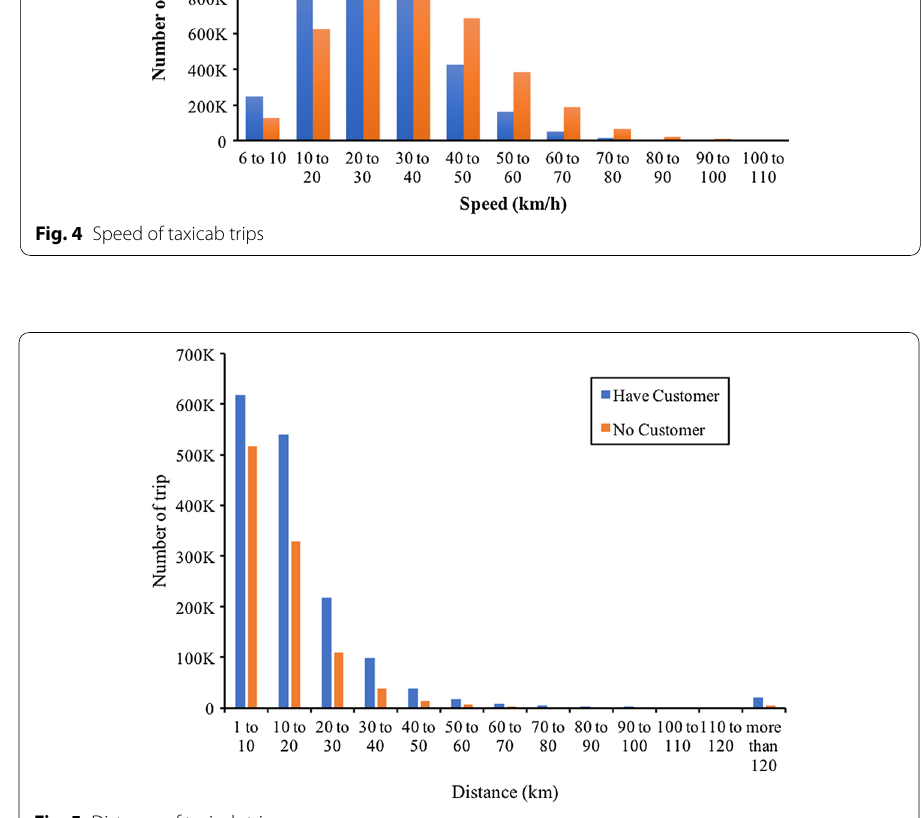
Fig. 5 Distance of taxicab